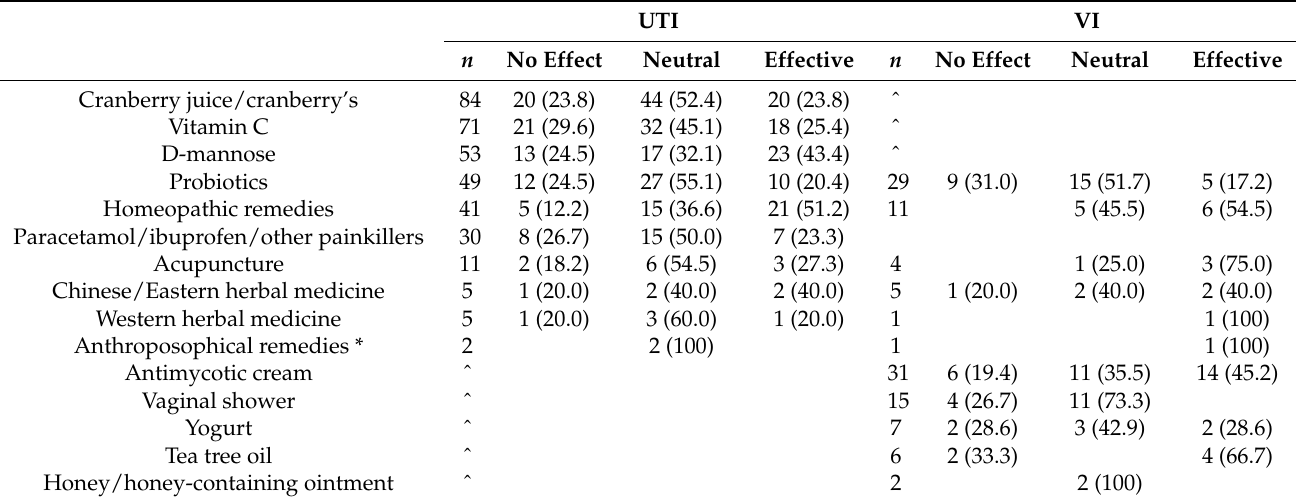
Table 3. Self-care and CM for UTI /VI in women with a history of UTI ( n = 162) and women with a history of UTI and VI ( n =